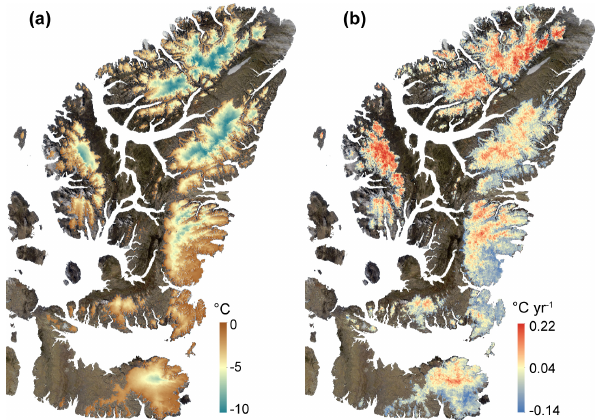
Figure 7. QEI (a) 16-year average mean summer land surface tem- perature ( ◦ C) and (b) linear rate of change of mean summer LST ( ◦ C yr − 1 ) for the period 2001–2016 over the QEI ice caps. Back- ground image: MODIS, 4 July 2011. Brown indicates non-glaciated land